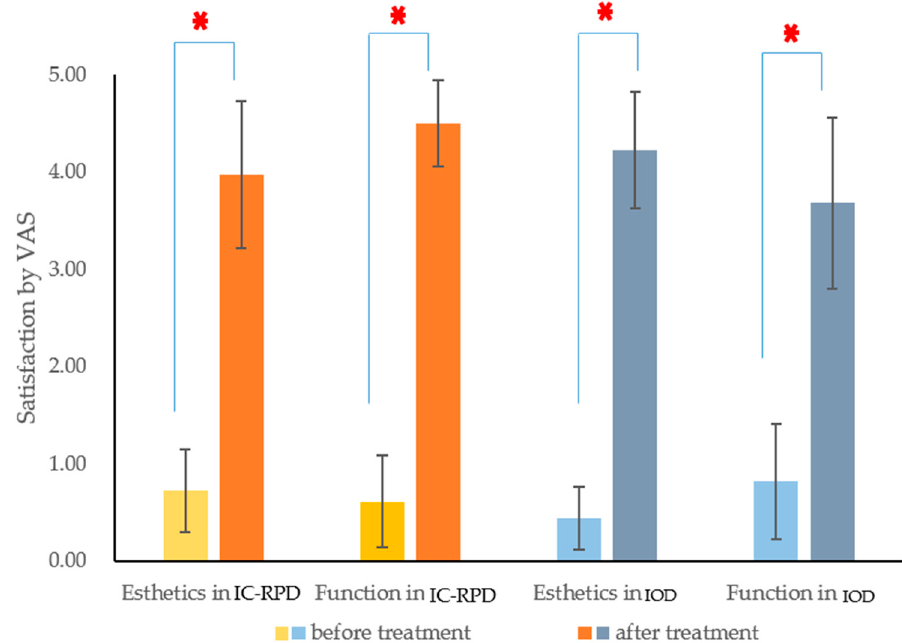
Figure 4. Comparison in satisfaction rate (esthetic and function) by VAS before vs. after prosthetic treatment. The Wilcoxon- Signed Ranks test showed there were significant differences before and after treatment in both esthetics and function regardless of the treatment modalities ( p < 0.05). Asterisk (*) indicated statistical differences ( p <